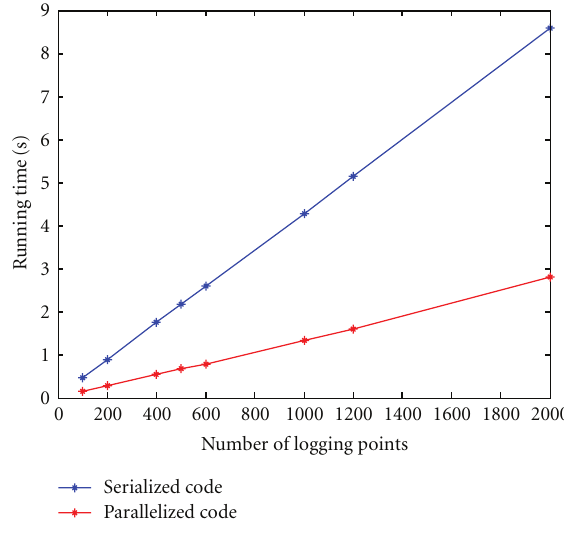
Figure 20: Comparison of the time cost for di ff erent number of threads.